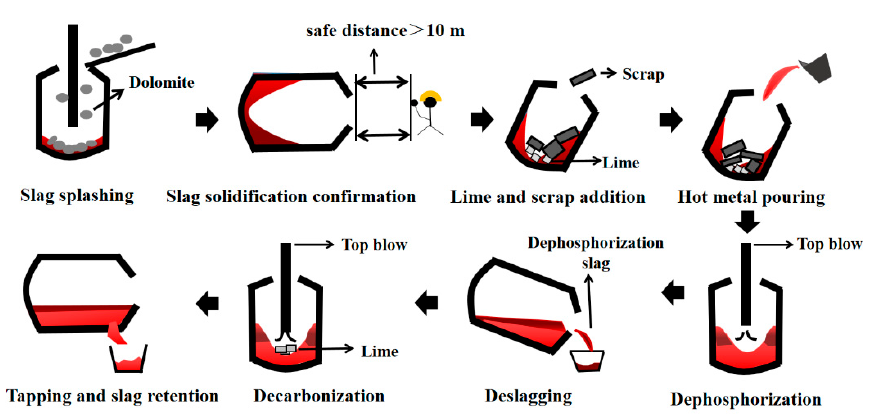
Figure 1. Flow chart of double slag converter steelmaking process.